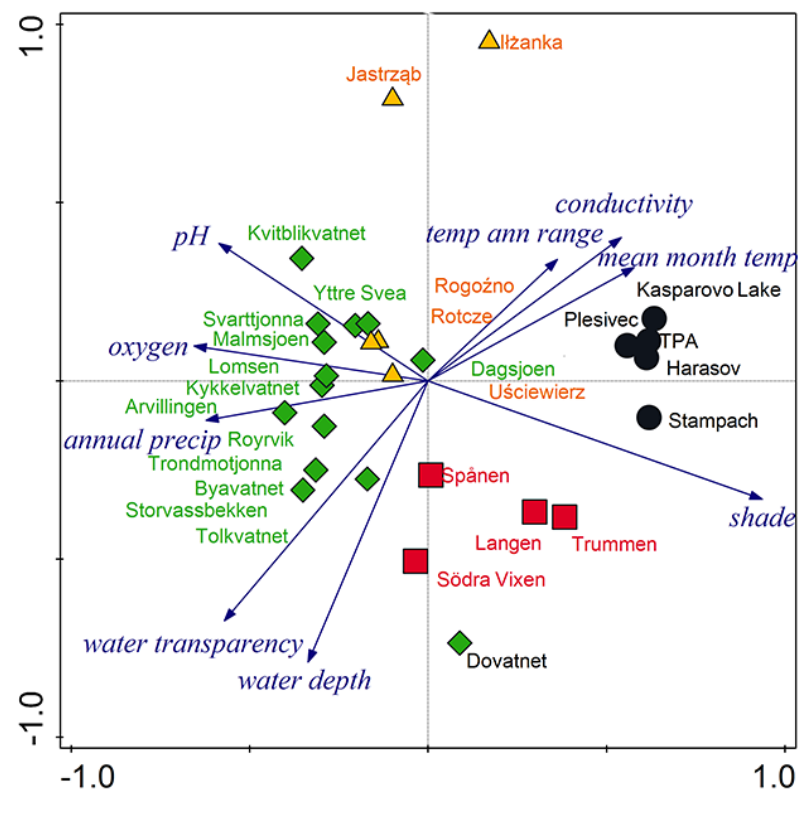
Figure 2 PCA of ecological variables. Comparison of localities with Potamogeton praelongus in the Czech Republic (black circles), central Poland (yellow triangles), Norway (green diamonds), and south Sweden (red squares). e first axis explains 54% of data variability, while the first two axes explain together 75% of data